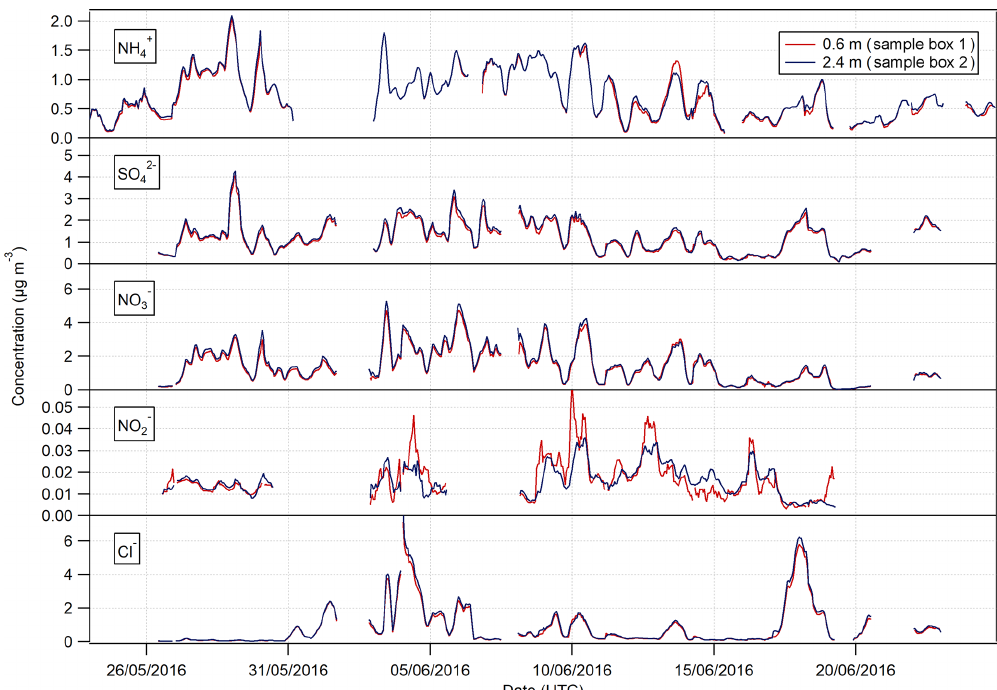
Figure 3. Time series of hourly concentrations of the water-soluble aerosol species measured during the Easter Bush campaign. Results smoothed using a 5h moving point average.